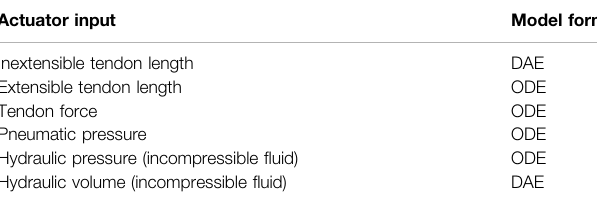
TABLE 2 | Model form as an ODE or DAE system based on actuator type, assuming a single rod model architecture for the model. Actuator